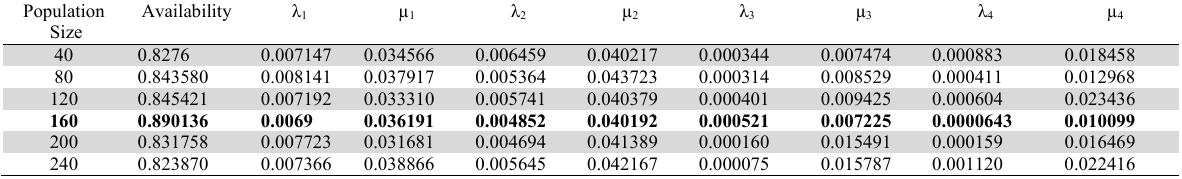
Effect of Population Size on the Availability of FFS Using Teaching Learning Based Optimization (TLBO) Population Availability λ 1